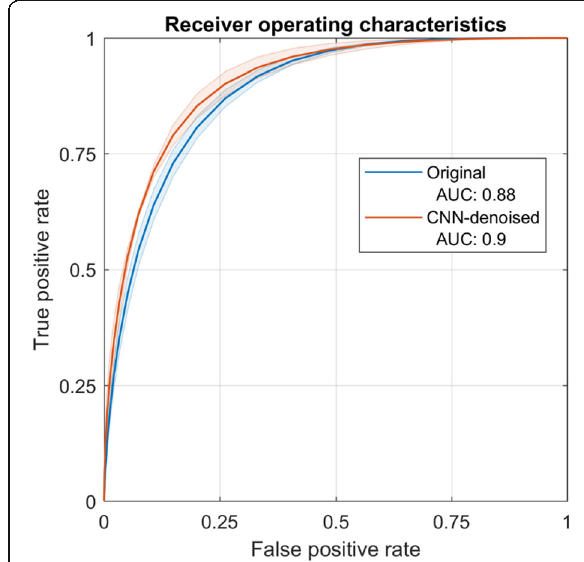
Fig. 8 Receiver operating characteristic curves estimated from the confidence-weighted detections of the physician readers — again, the observer means are given by the solid lines, and the shaded regions denote the inter-observer standard deviation. Small overall differences were found between performance within the original and CNN-denoised